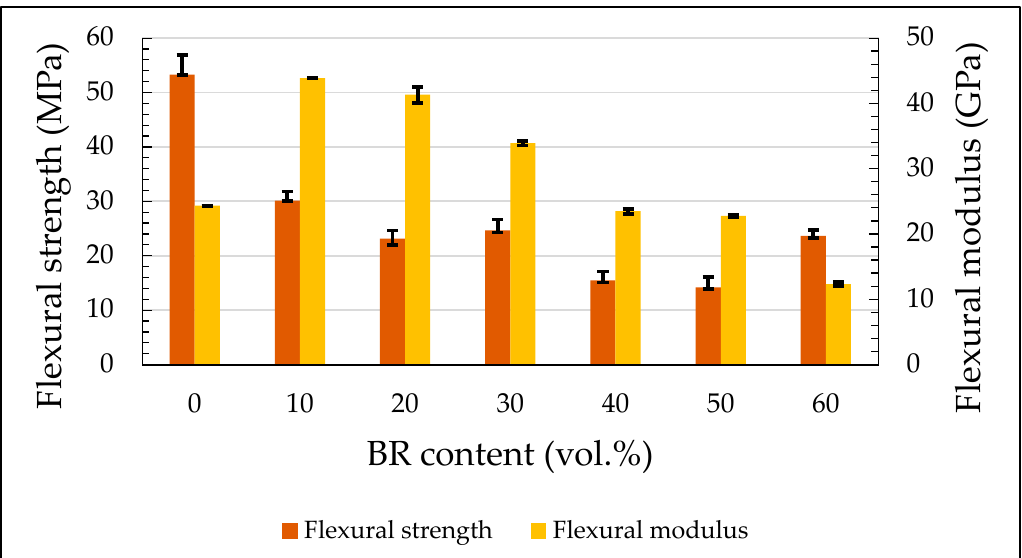
Figure 11. Effects of BR vol.% on the flexural strength and modulus of the BR–UPR composites.